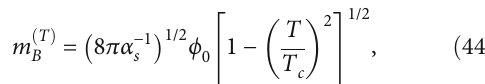
ð θ Þ as a function of θ for di ff erent R at α s = 0 : 12 , 0.24, 0.48, and 0.96 m